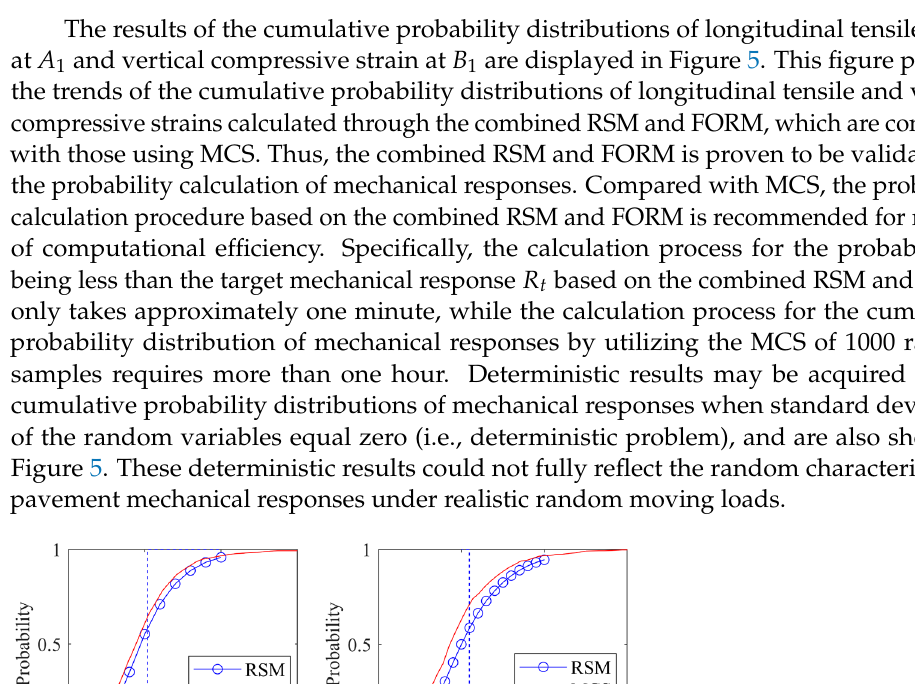
and ( b ) vertical compressive strain at B1 (SD0 = result for the random variables when standard de-